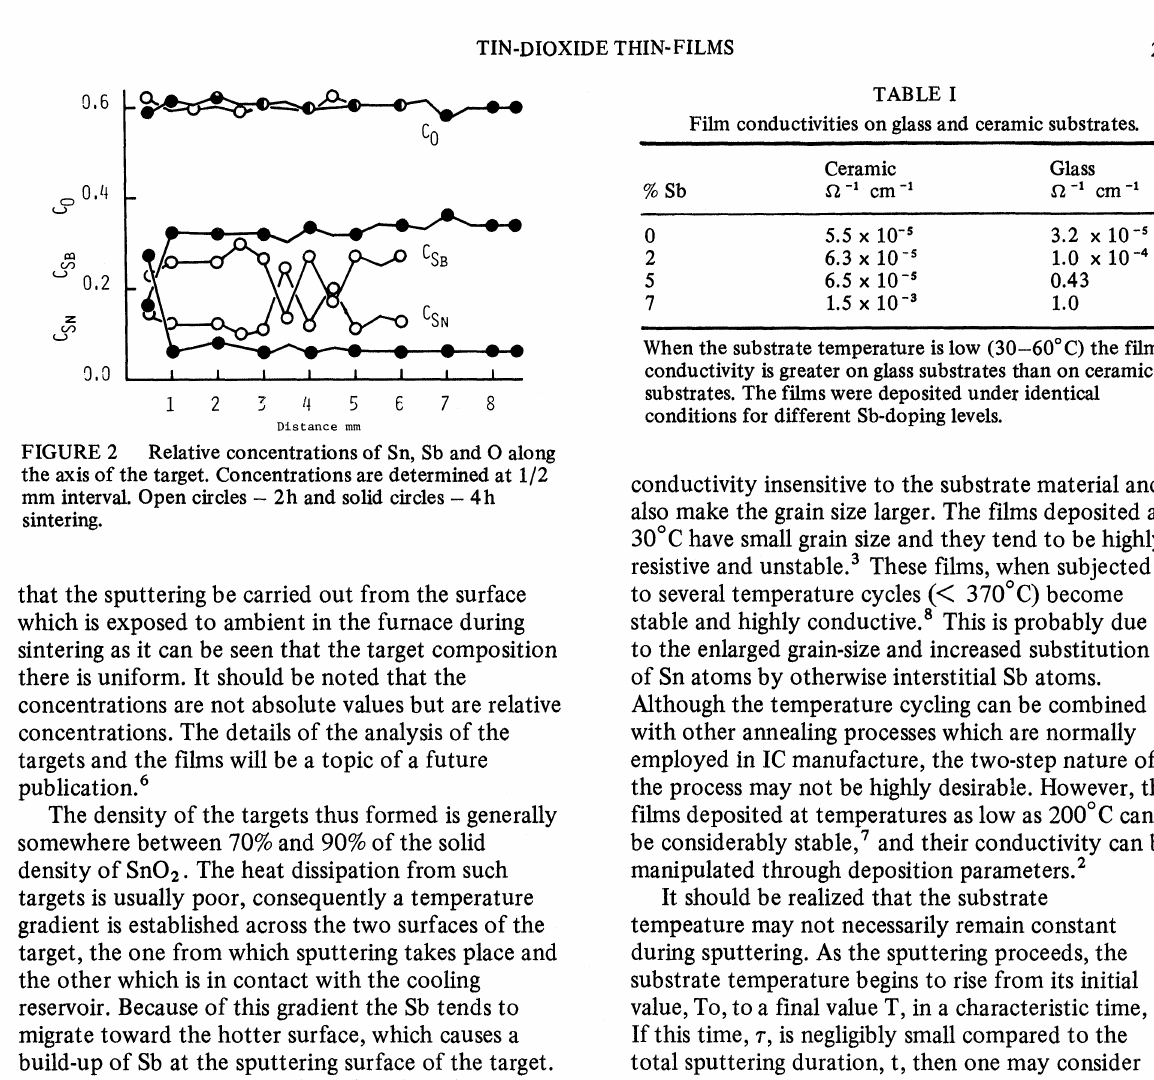
Film conductivities on glass and ceramic